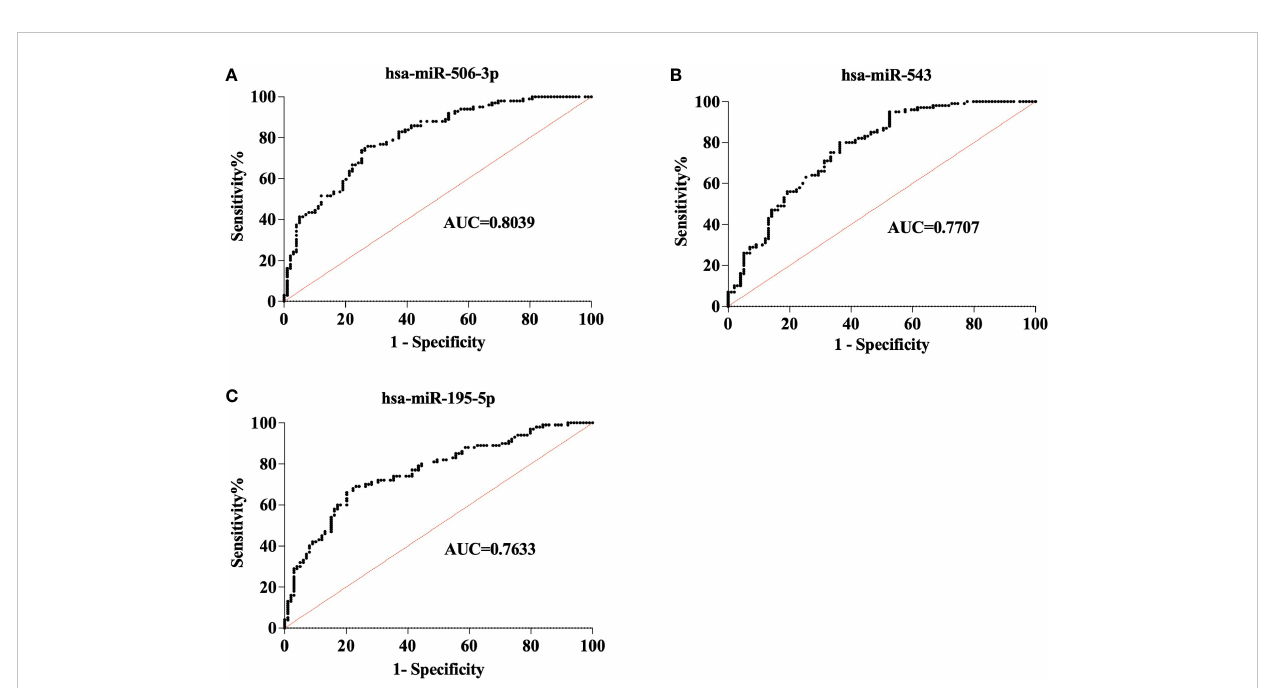
FIGURE 2 Receiver operating characteristic (ROC) analysis of 3 miRNAs in the training cohort. ROC curve shows the diagnostic performance of 3miRNAs in the training cohort (CONT = 100, STB= 100). (A) . hsa-miR-506-3p (AUC = 0.8039) (B) . hsa-miR-543(AUC=0.7707) (C) .